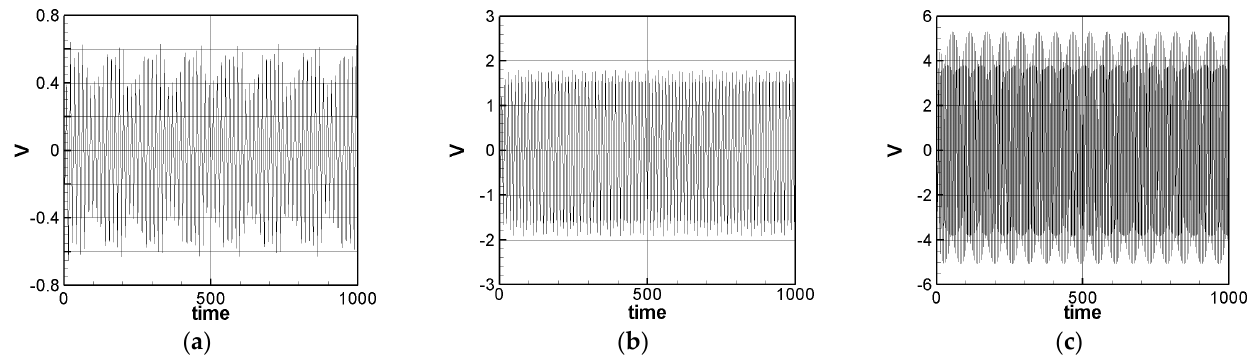
Figure 13. DES VEH system theoretical voltage output (dimensionless). ( a ) 1st mode, ( b ) 2nd mode, and ( c ) 3rd mode.